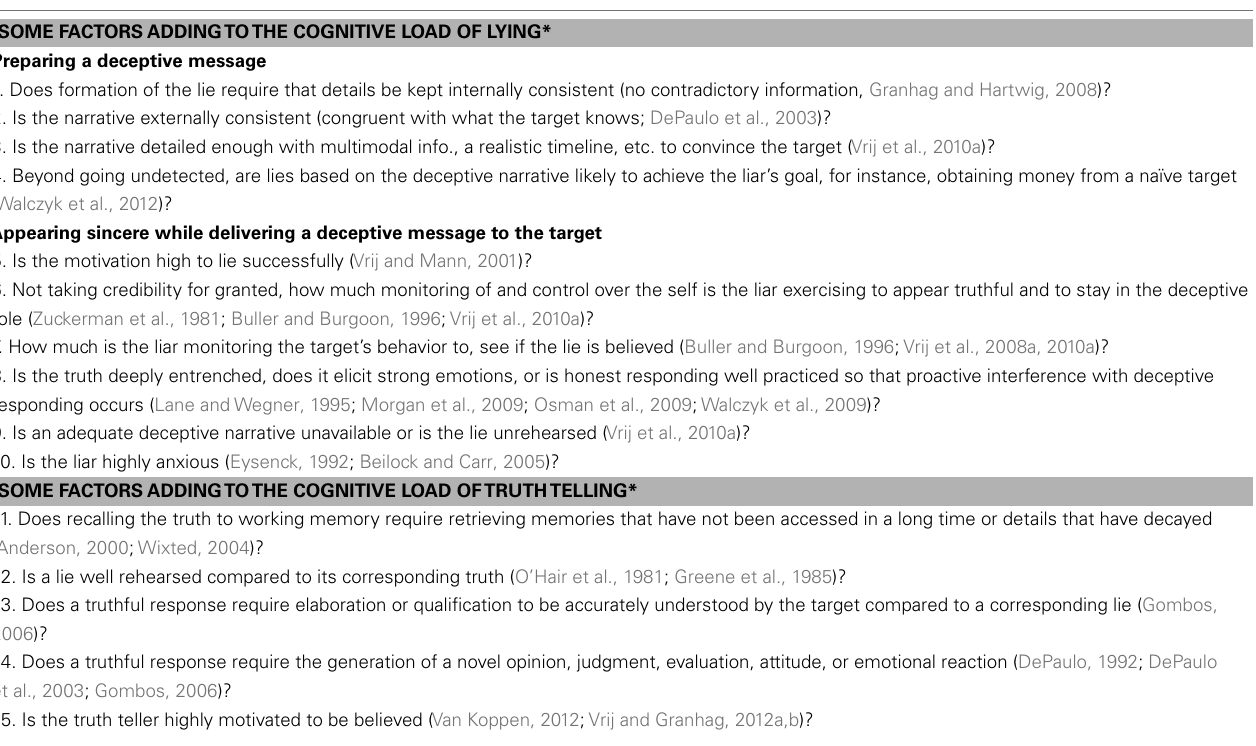
Table 1 |The cognitive load of lying versus truth